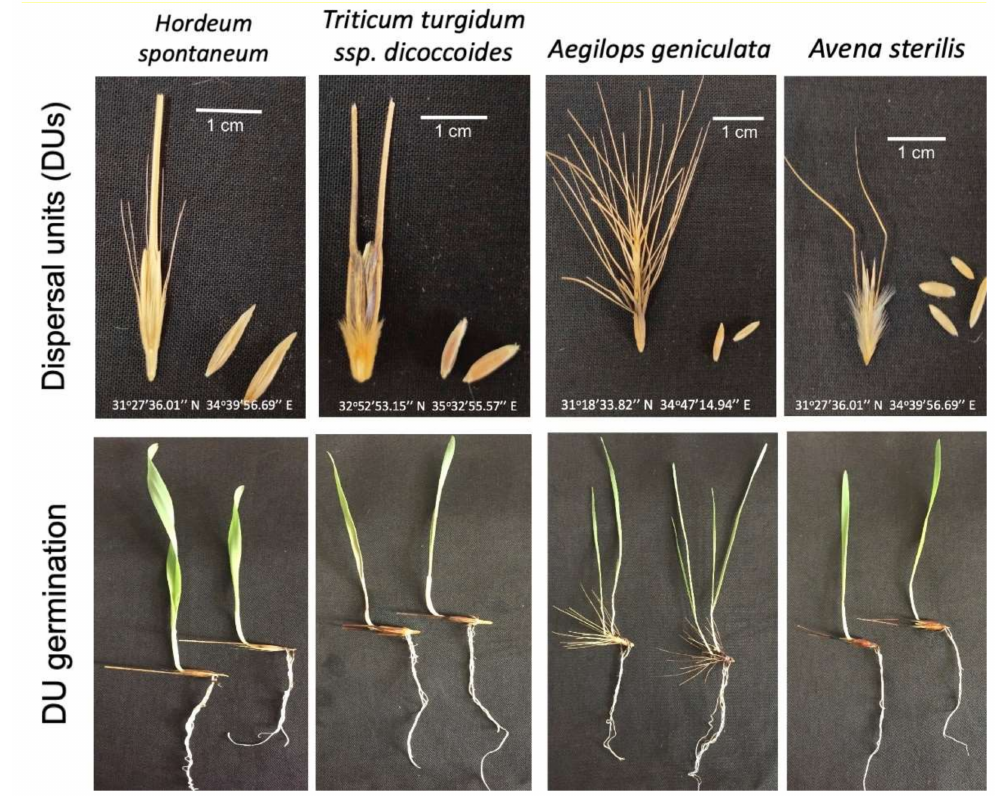
Figure 1. Dispersal units (DUs) and caryopses of Poaceae species and their germination. Note the awns of Hordeum and Triticum species were trimmed. DUs were collected from natural populations within agricultural and pasture areas (see GPS coordinates) during May 2021, except for T. turgidum var. dicoccoides , which was collected during June 2019. All DUs were stored at room temperature and sown at mid Sept. 2021. Seedlings were photographed seven days after